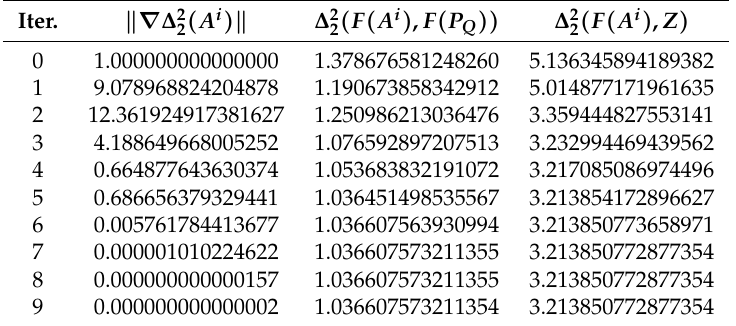
-Newton method for MOP (53) when Z is a triangle, see Figure 15. 2